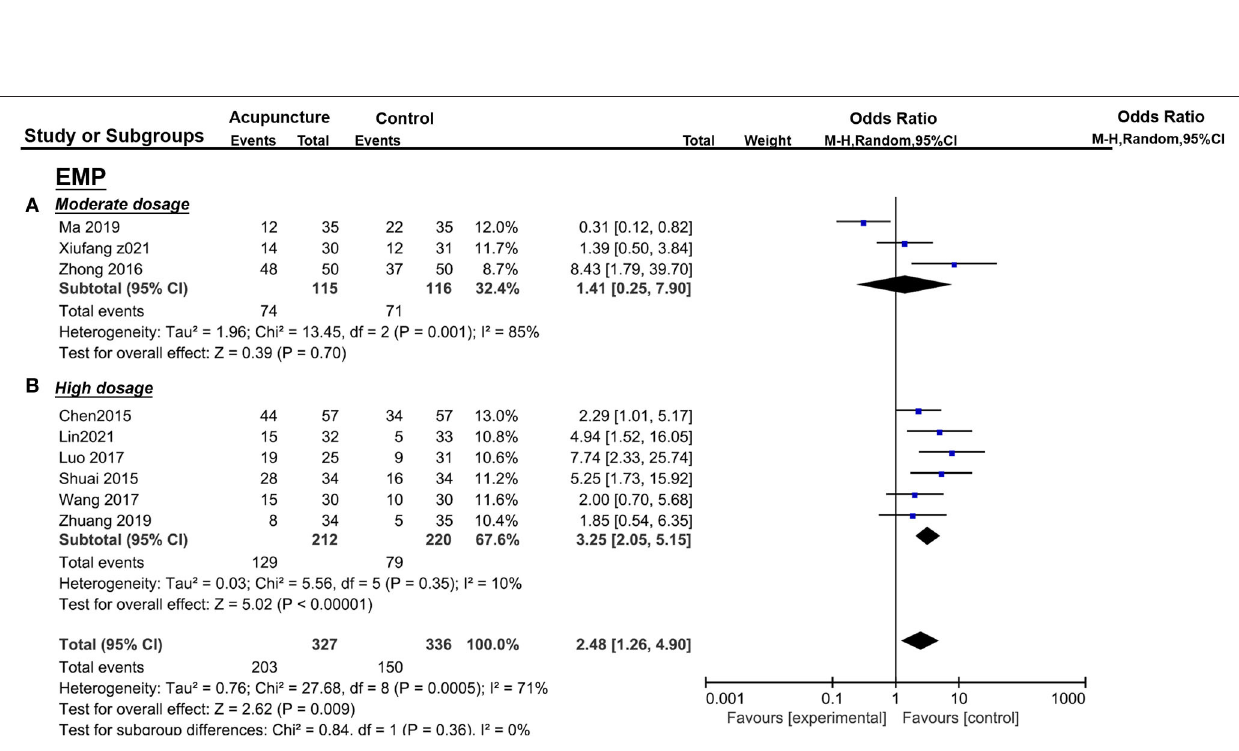
FIGURE 10 | Effects of acupuncture on EMP based on intervention of moderate dosage (A) and high dosage (B) .